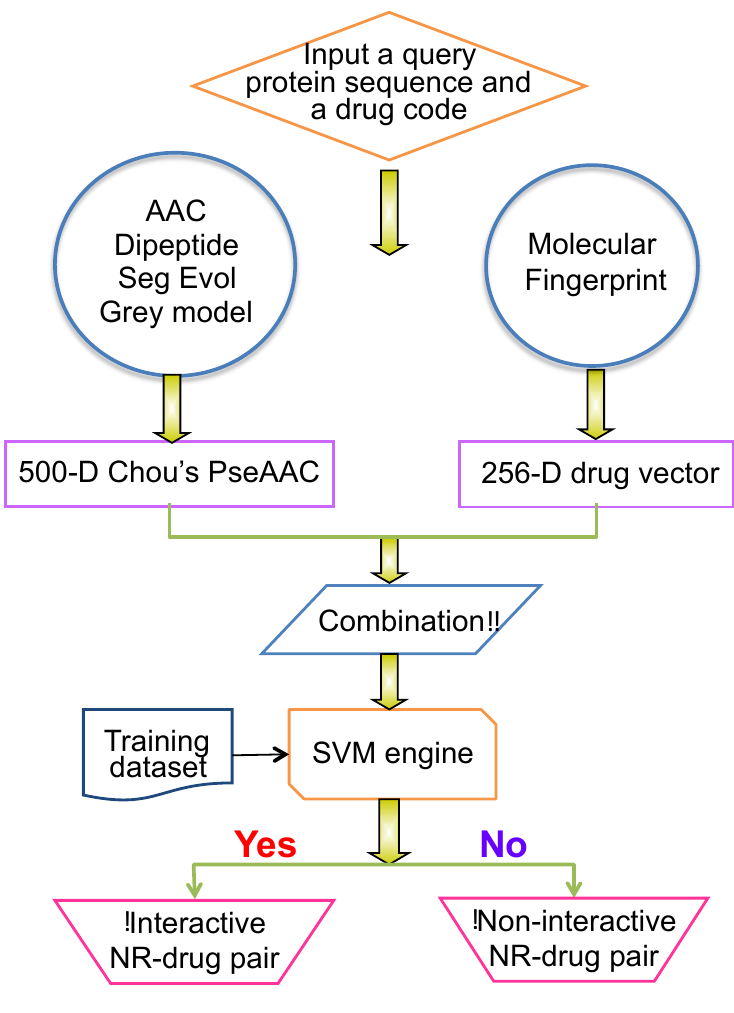
Figure 2. A flowchart to show the operation process of the iNR-Drug predictor. Input a